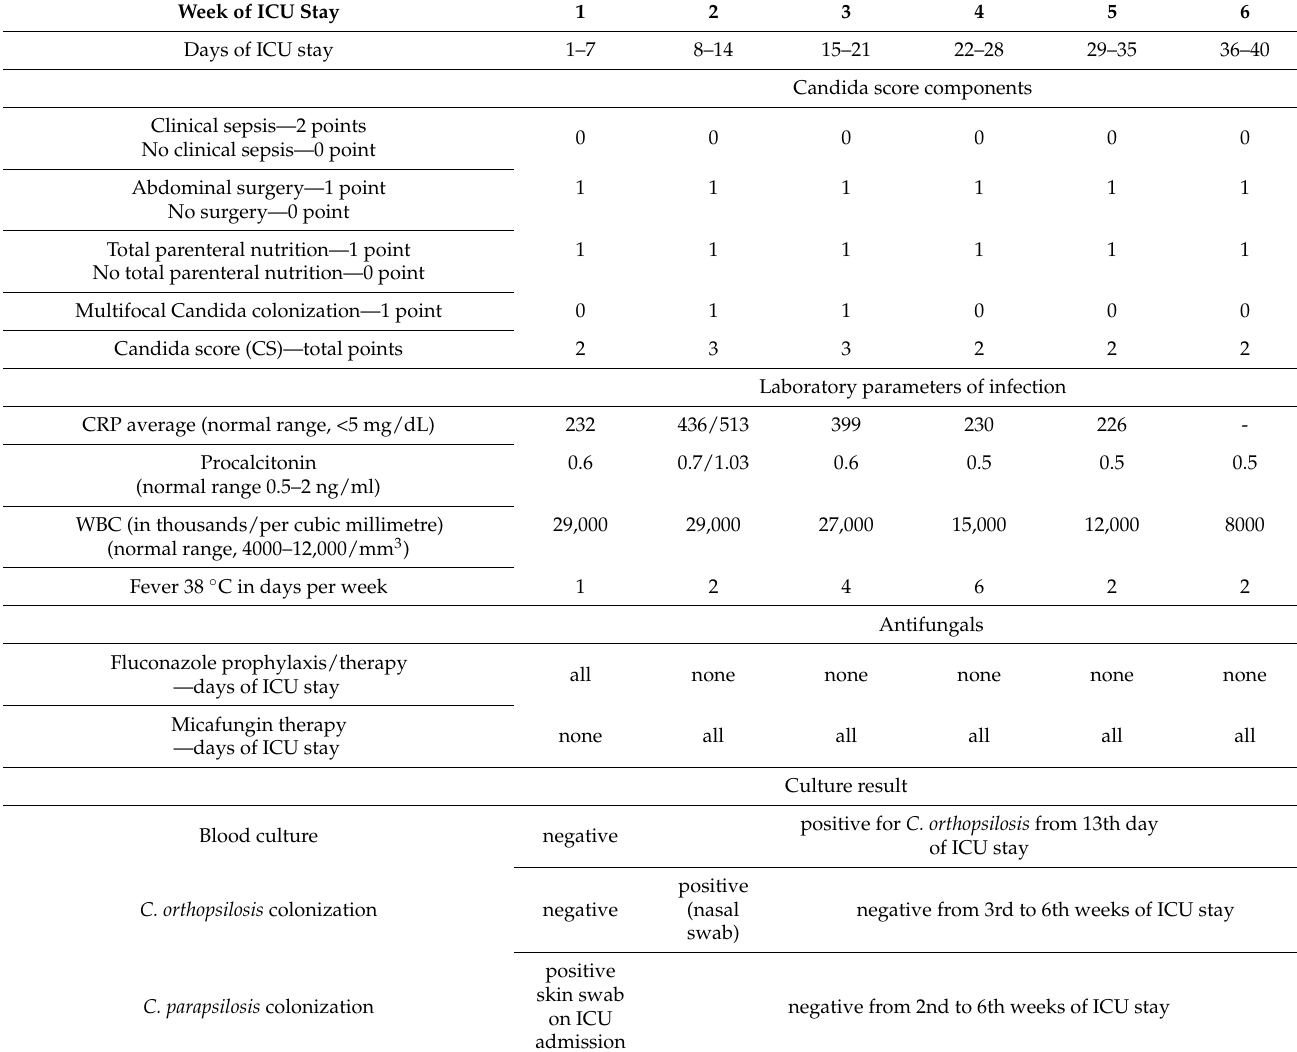
Table 1. Clinical and diagnosis data of 59-year-old male patient with CBSI caused by C. orthopsilosis